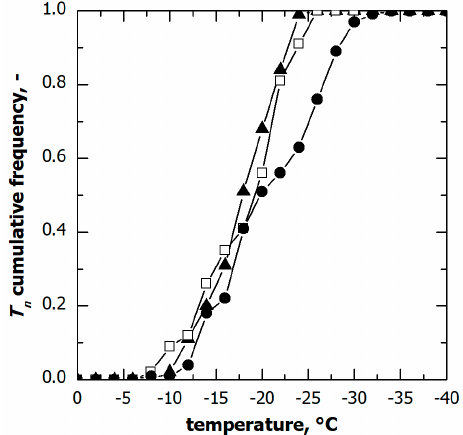
Figure 4. Cumulative distribution for the ice nucleation temperature in the case of vials in direct contact with the shelf. Data refer to various cooling rates: ( ▲ ) 0.25, ( □ ) 0.50, and ( ● ) 1.00 °C min − 1 . On the contrary, at the highest cooling rate, i.e., 1 °C min − 1 , a significant fraction of vials (approximately 30%) nucleated below − 25 °C, although the median nucleation